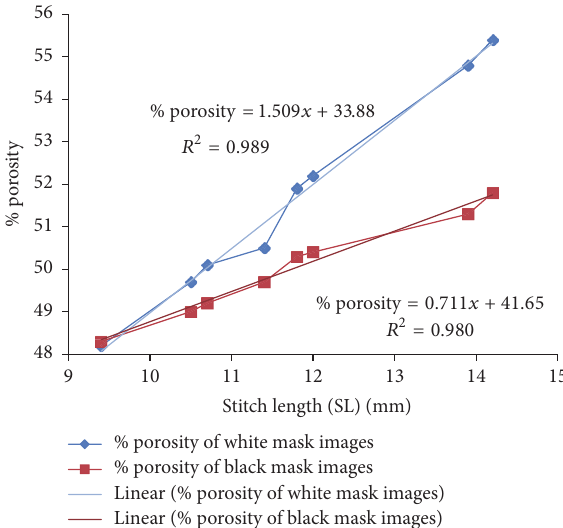
Figure 8: Percentage porosity against stitch length (SL) for plain structure for FKM.